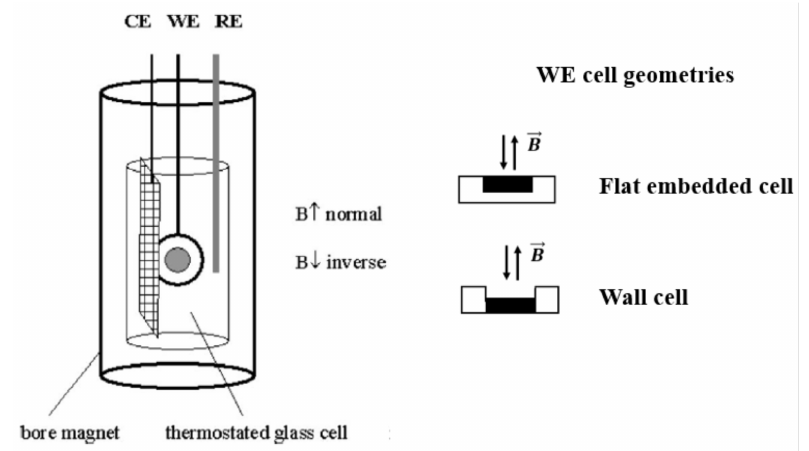
Figure 5. Principle experimental setup. The two working cell geometries used were a flat embedded electrode and a wall electrode. CE is the counter electrode, WE is the working electrode, and RE is the reference electrode. The magnetic field was applied as indicated